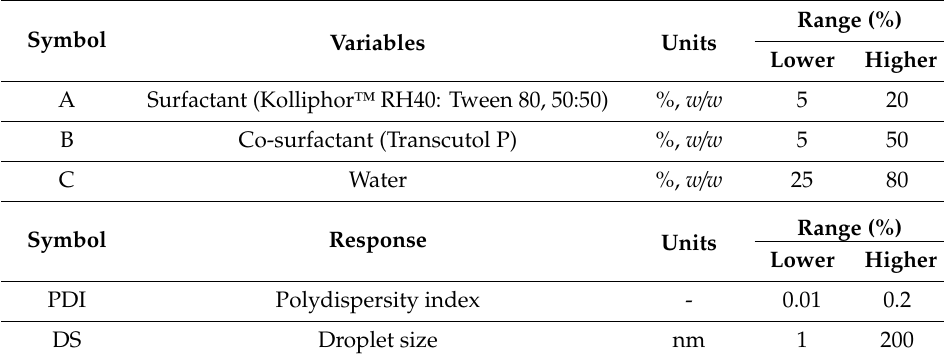
Table 1. Restrictions of variables and response on quality-by-design (QbD).